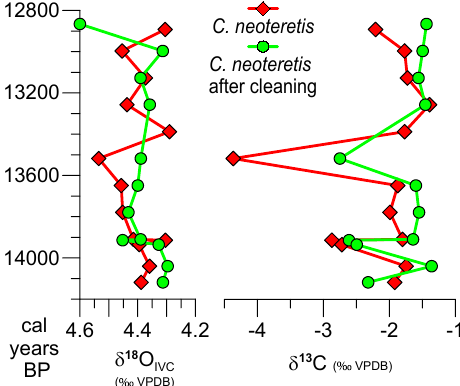
Figure 5. Detail of the δ 18 O and δ 13 C record of C. neoteretis from CIE I interval, before (red line) and after (green line) the cleaning protocol of Pena et al. (2005).